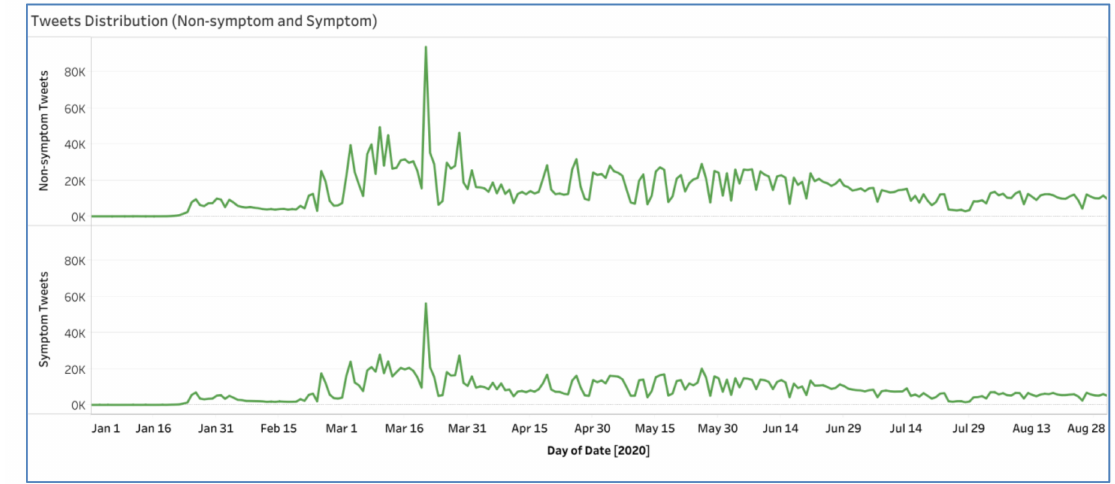
Figure 8. Symptom Distribution.